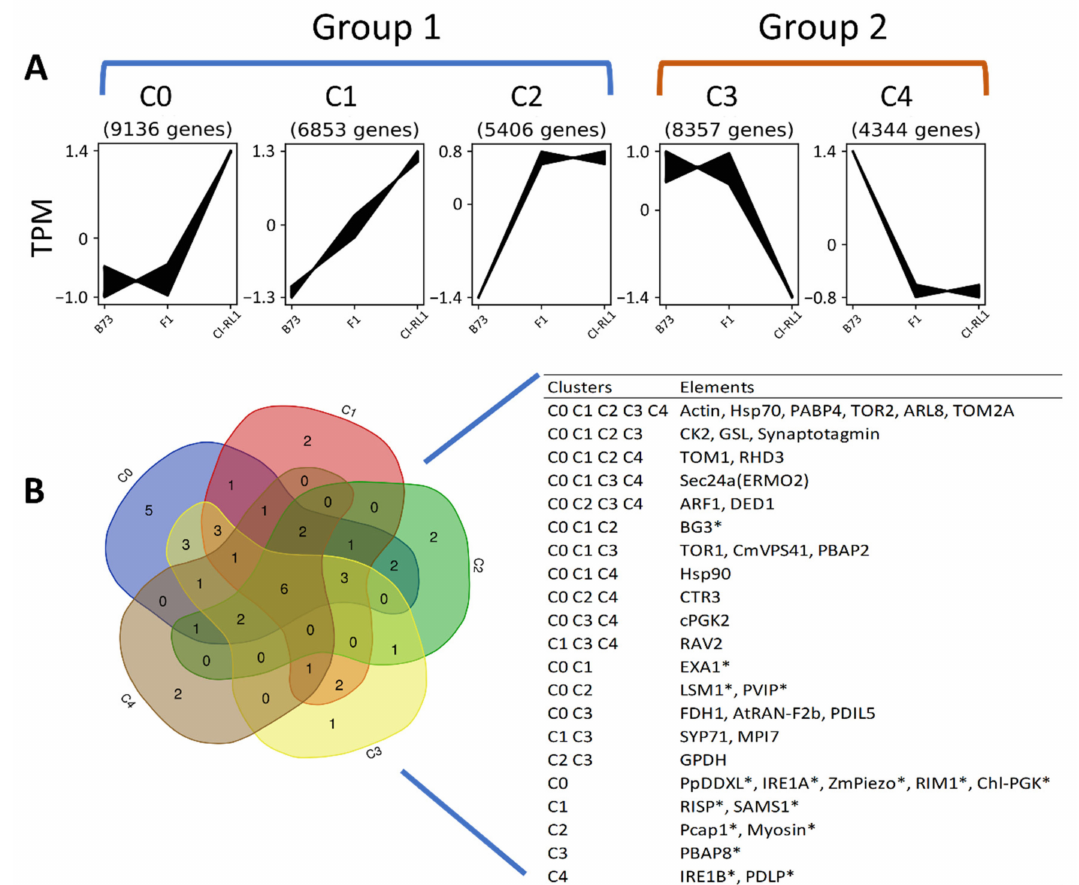
Figure 2. Cluster groups of transcript expression patterns (non-DEGs) in three maize lines: B73, F1 (B73 × CI-RL), and CI-RL1. ( A ) Group 1, with C0 to C2 clusters having high expression levels for CI-RL1; Group 2, including C3 and C4 clusters with low expression levels for CI-RL1. ( B ) Venn diagram of 43 selected candidate genes present in one or more expression pattern clusters. * Set of sixteen candidate genes found in only one group (Group 1 or